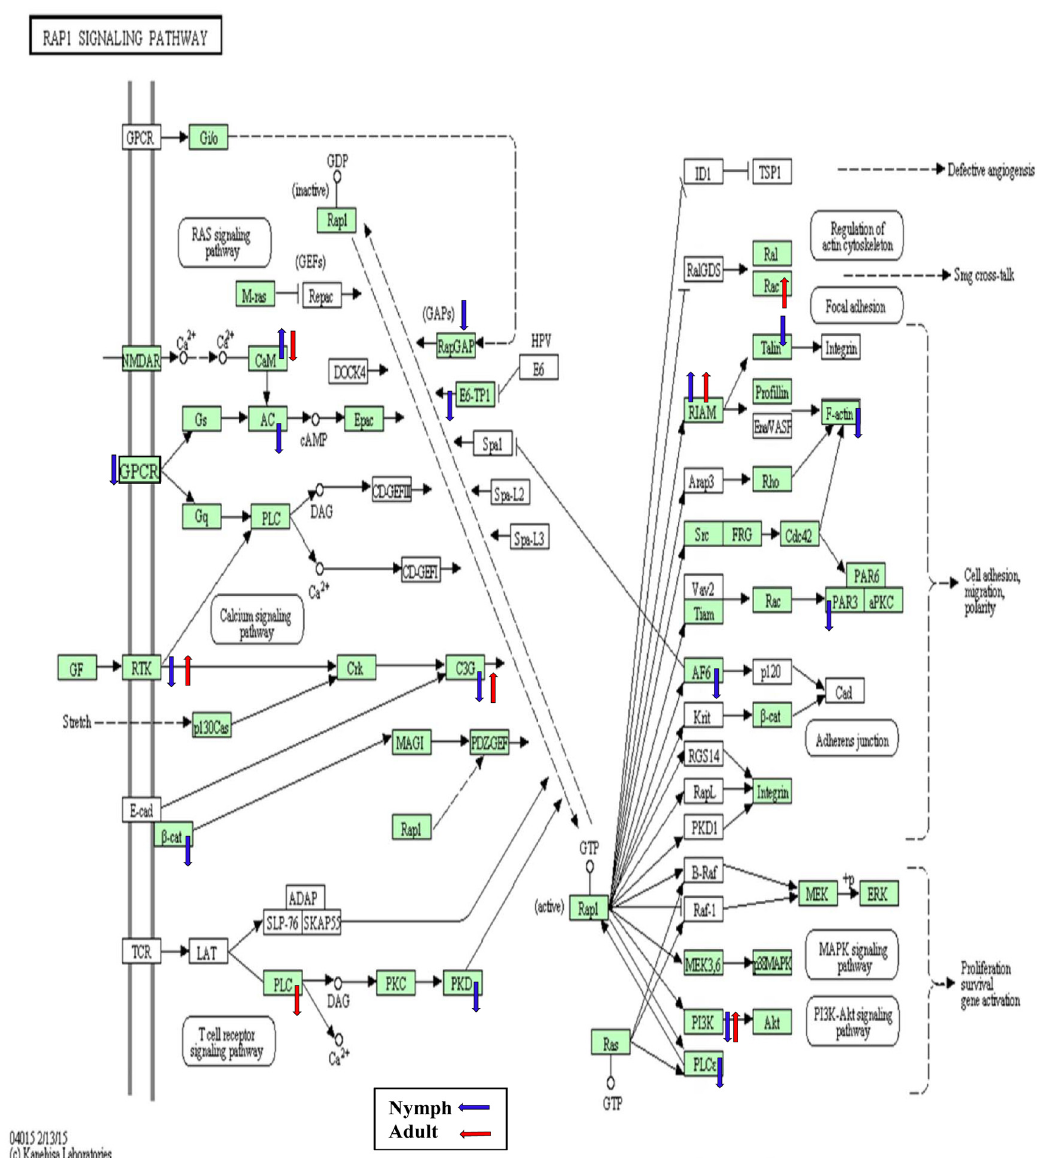
Fig 6. The Rap 1 signaling KEGG pathway diagram showing the contigs that were differentially expressed ( p < 0.05) in nymphs (blue arrows) and adults (red arrows) in response to CLas infection. Of the assigned contigs (shaded in green), 18 were differentially expressed either in the nymphs or